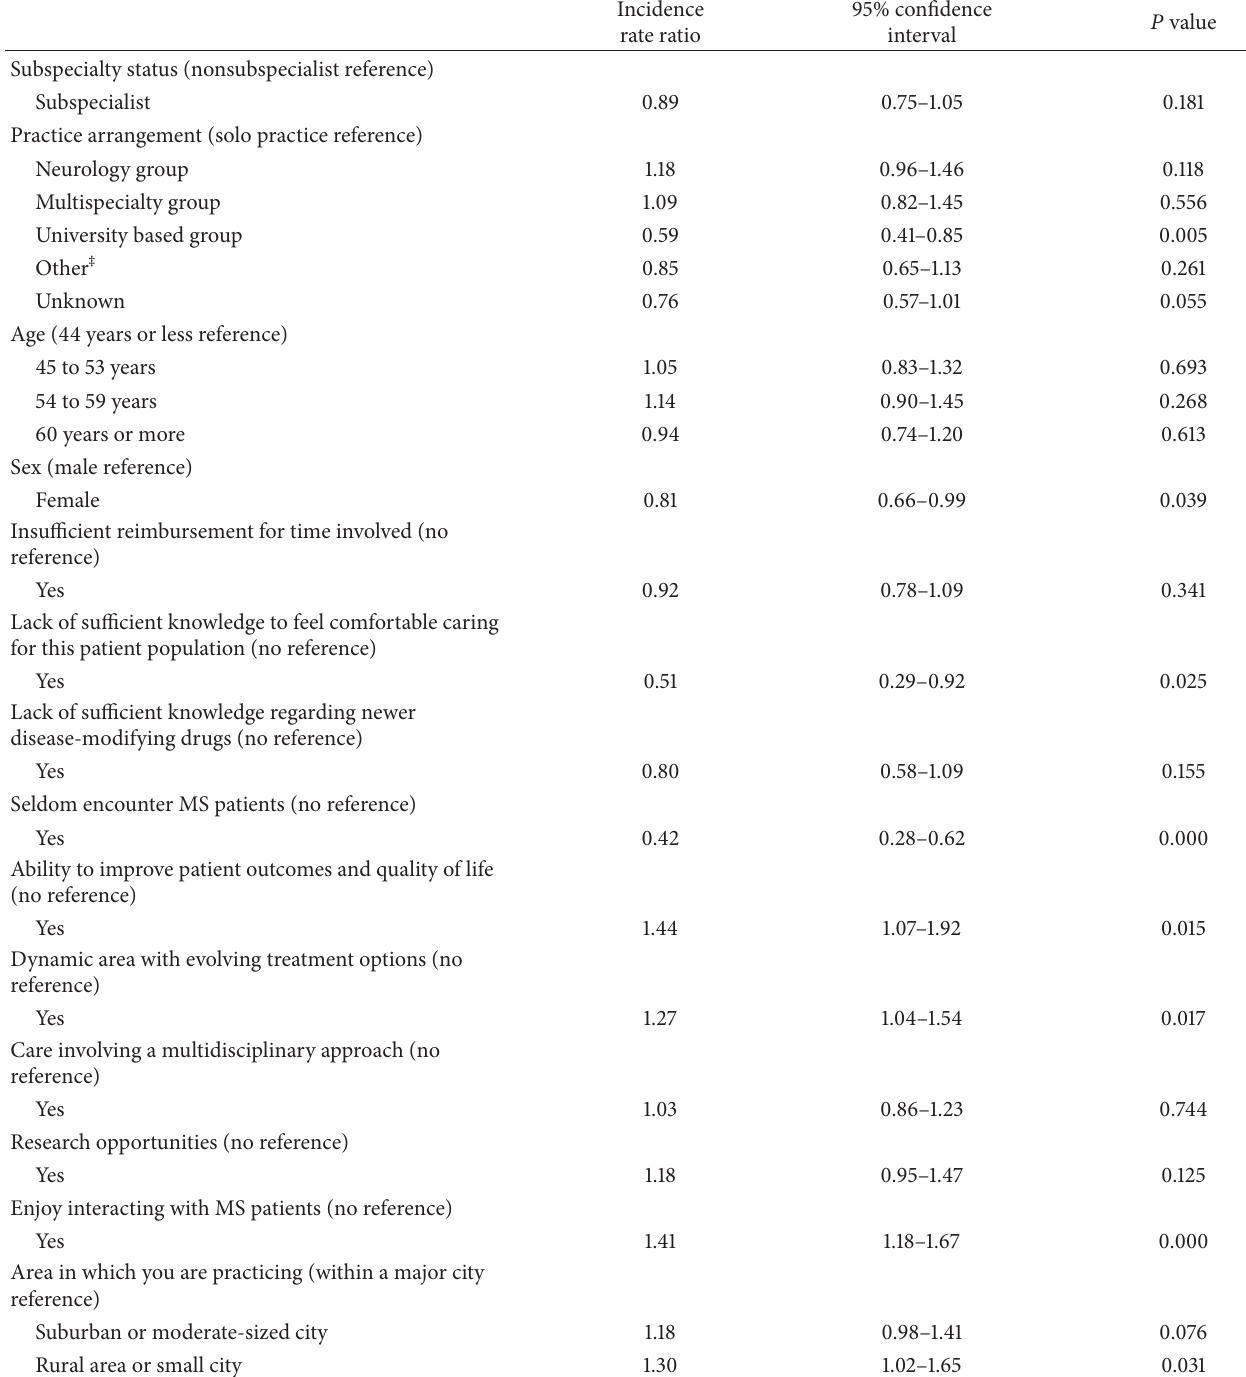
Table 4: Negative binomial regression predicting MS patients seen per week among Non-MS subspecialists/general